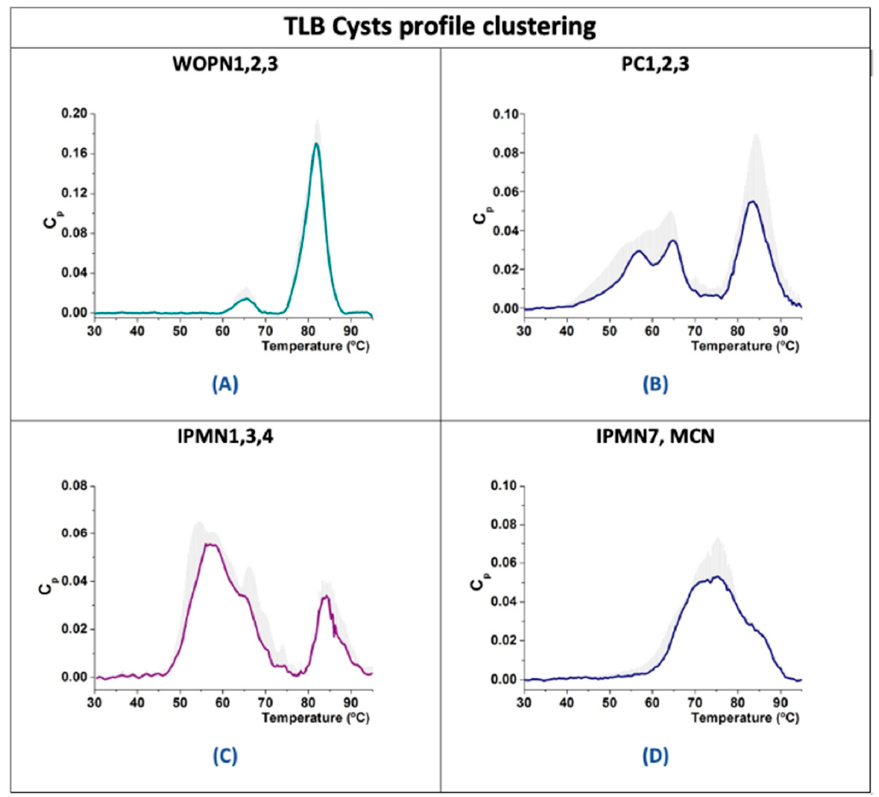
Figure 2. TLB thermograms from cystic liquid samples clustered according to their type. Average curves (colored lines) and standard deviations of curve values (grey) are represented: WOPNs ( A ),